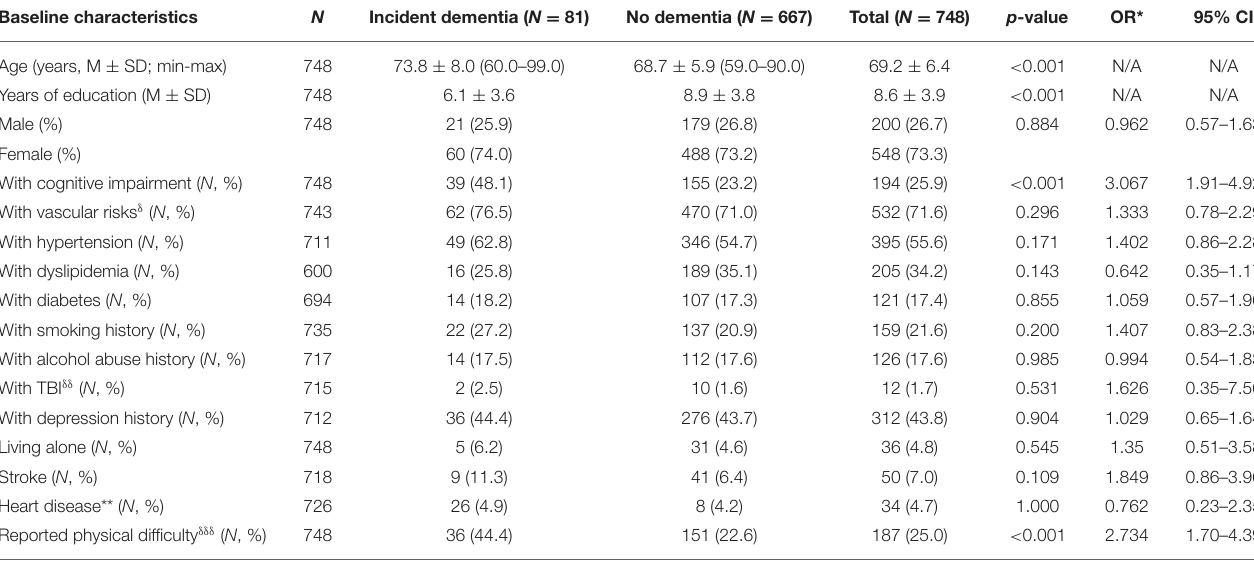
TABLE 1 | Baseline profile of participants with and without incident dementia.